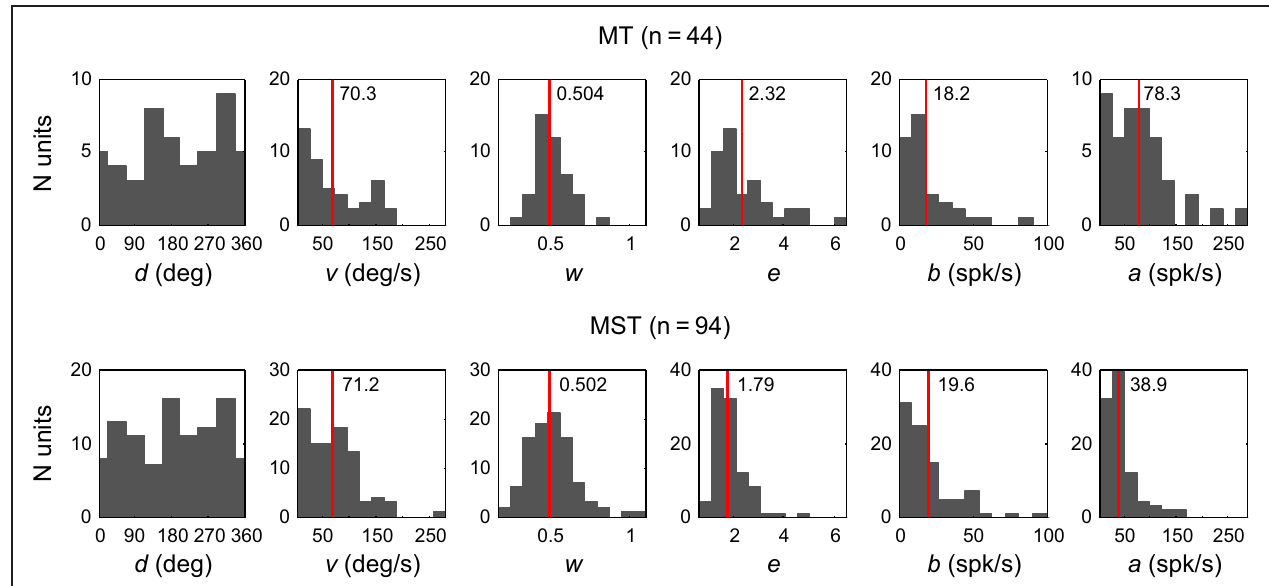
FIGURE 5 | Histograms of the fit estimates of the six-parameter model across the population of MT units (Top) and MST units (Bottom). Red vertical lines indicate the means.